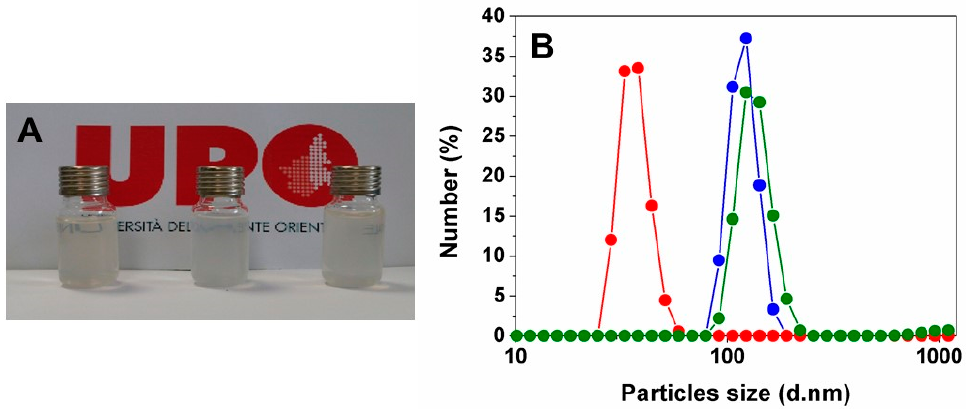
Figure 3. ( A ) Digital photograph of aqueous suspensions of Gd 2 O 3 , Gd 2 O 3 :Yb (LL) and Gd 2 O 3 :Yb (HL) (from left to right); ( B ) dynamic light scattering (DLS) analysis of Gd 2 O 3 (red), Gd 2 O 3 :Yb (LL) (green) and Gd 2 O 3 :Yb (HL) (blue) suspensions.